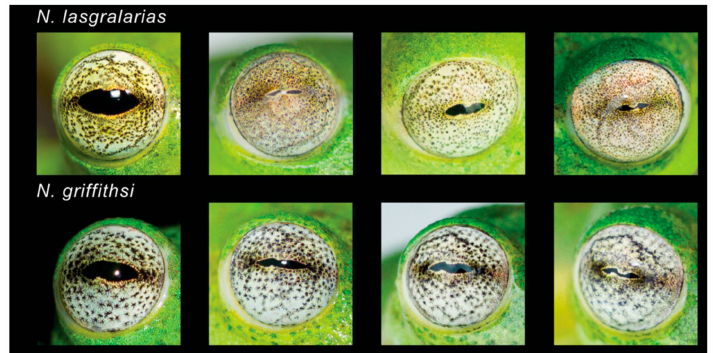
Figure 160. ( Top Row ): Iris of Nymphargus lasgralarias . ( Bottom Row ): Iris of N . gri ffi thsi . Modified from Hutter and Guayasamin